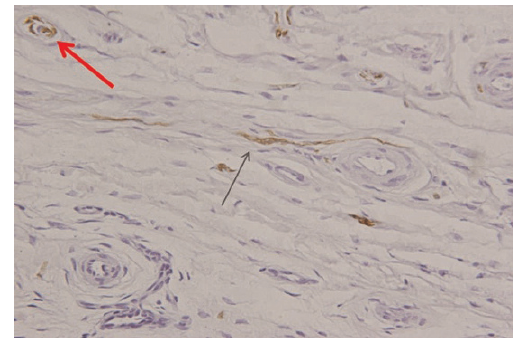
Figure 2 - Immunomarking for S100 (200 6 magnification). Presence of a type II mechanoreceptor (Pacinian corpuscle) in the upper left field (red arrow) and a type IV mechanoreceptor (perivascular terminations) in the center of the image (black arrow).